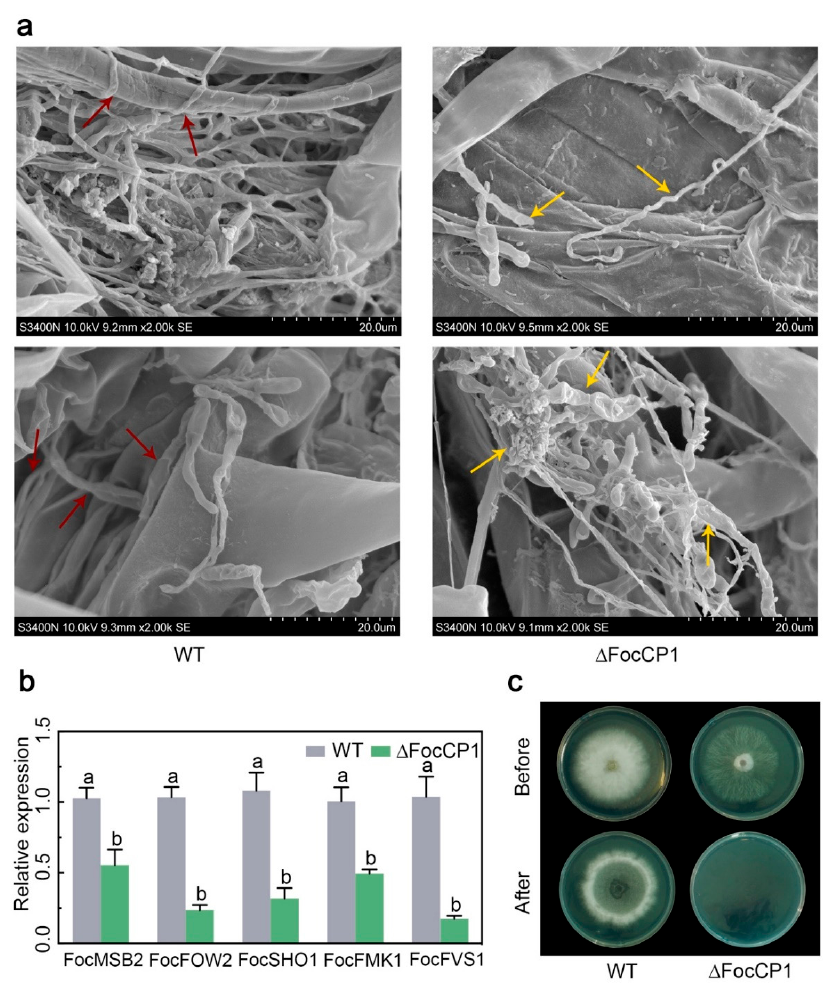
Figure 7. FocCP1 is required for successful penetration of Foc into banana roots. ( a ) Comparison of infection behaviour of the WT and ∆ FocCP1 strains on banana roots. Red arrows indicate penetration events and yellow arrows indicate unsuccessful penetration events. ( b ) Expression of infection-related genes of the WT and ∆ FocCP1 strains. Data are the means ± SDs from three independent experiments. Di ff erent letters above the columns indicate significant di ff erences at p < 0.01 (Student’s t -test) between the WT and ∆ FocCP1 strains. ( c ) Comparison of the penetration ability against cellophane membranes. Fungal colonies were grown for 3 days on top of cellophane membranes placed on minimal medium (before). The cellophane membranes were then removed and the plates were incubated for an additional 2 days to examine hyphal